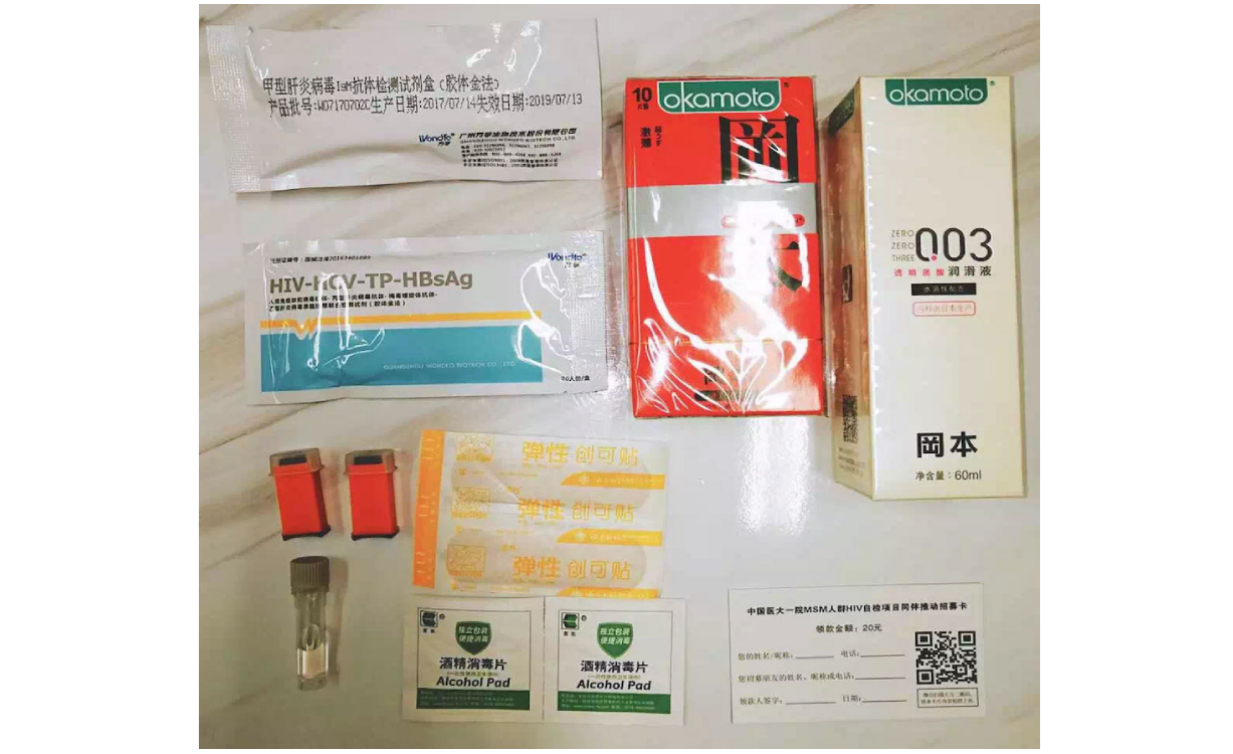
Figure 1. HIVST kits used in the